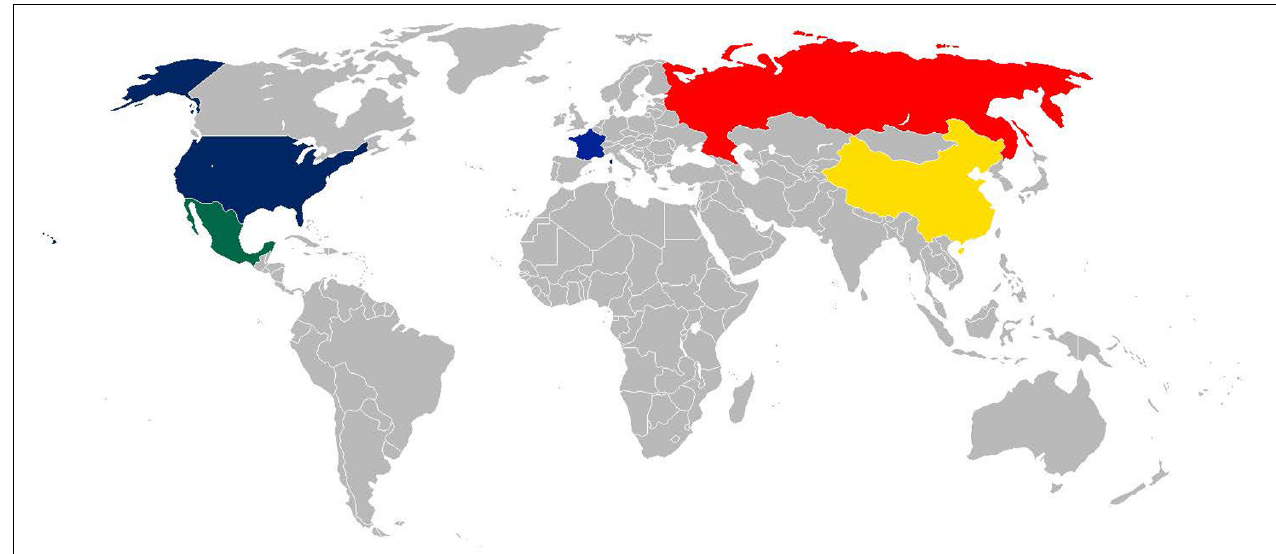
FIGURE 1 | World Map showing countries confirmed and suspected of being the origin of influenza pandemics. Blue – The origin of the 1918 Spanish is still unclear, although various papers suggest the United States (New York) or France as the origin; yellow – China the origin of the 1957 Asian flu pandemic; Hong Kong, the origin of the 1968 Hong Kong pandemic; red – Russia, the origin of the 1889 and 1977 Russian flu pandemics; green – Mexico, the origin of the 2009 Swine flu